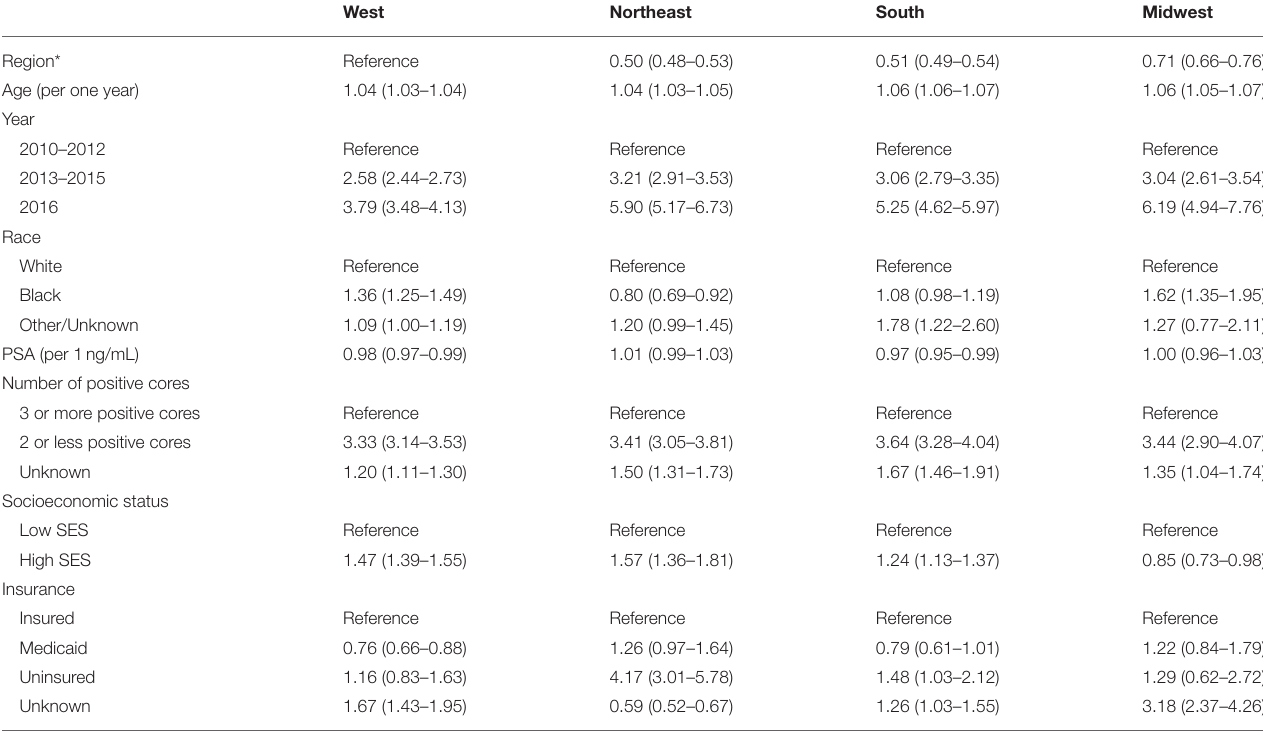
TABLE 3 | Multivariable logistic regression analysis assessing receipt of active